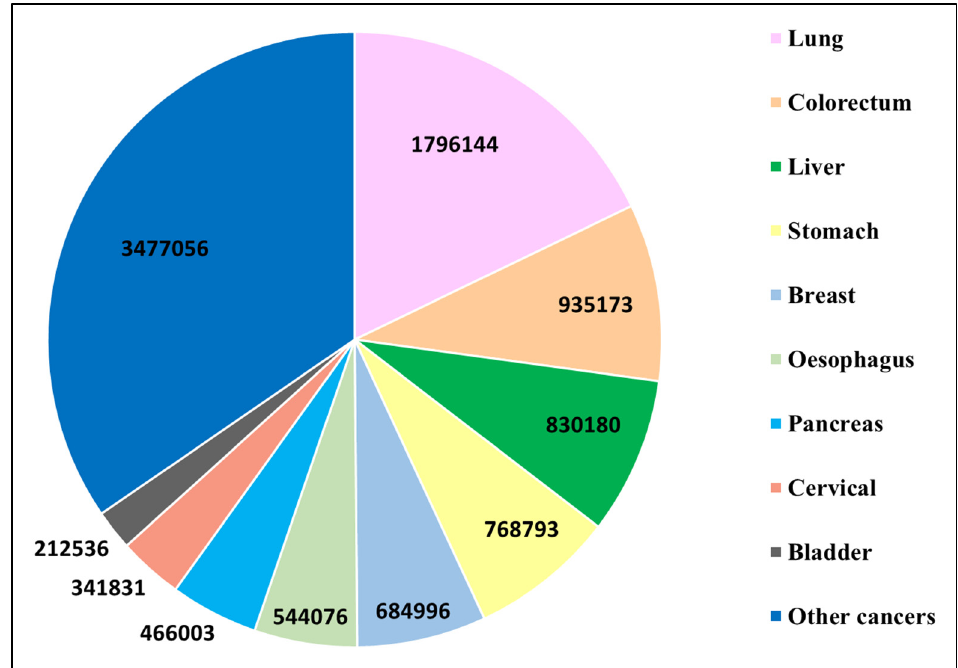
Figure 2. Global mortality numbers for different cancers in 2020. Adapted from [20].